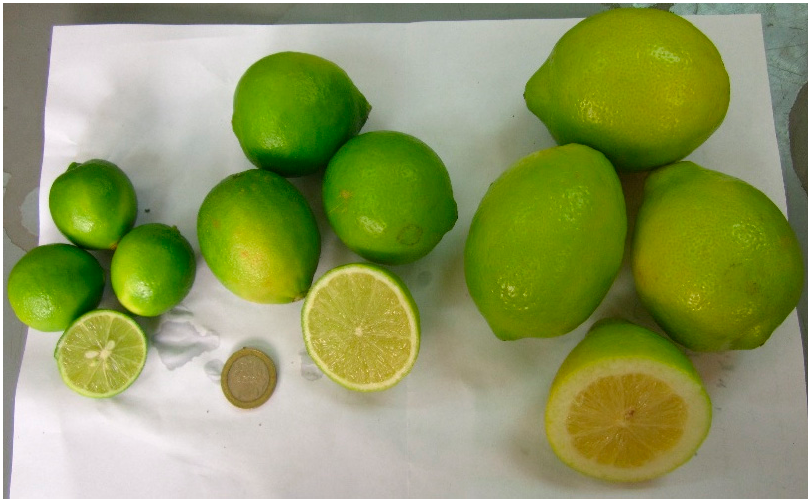
Figure 1. Pictures of Pica lemon ( right ), Sutil lemon ( middle ) and Genova lemon ( left ) from northern